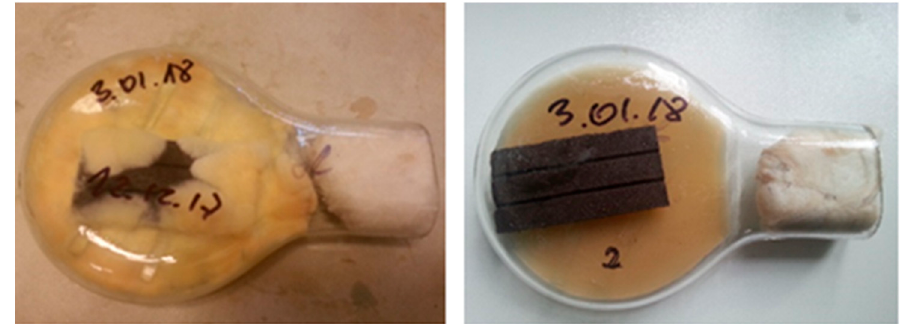
Figure 2. Kolle flask with Coniophora puteana —experimental chamber (on the left) and control chamber (on the right) after two weeks of incubation; photo taken by one of the contributing authors.